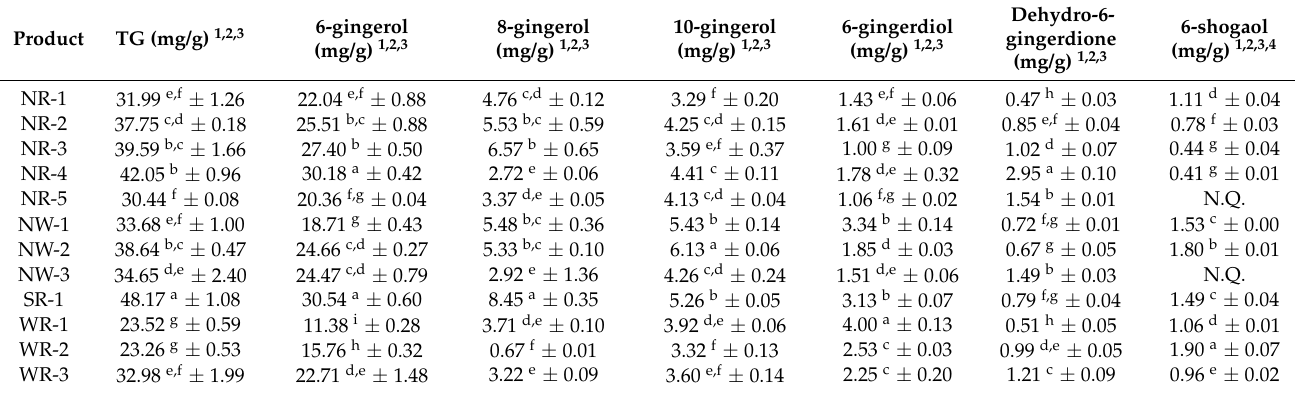
Table 2. Total gingerol (TG) and 6-shogaol content for extracts of Z. officinale